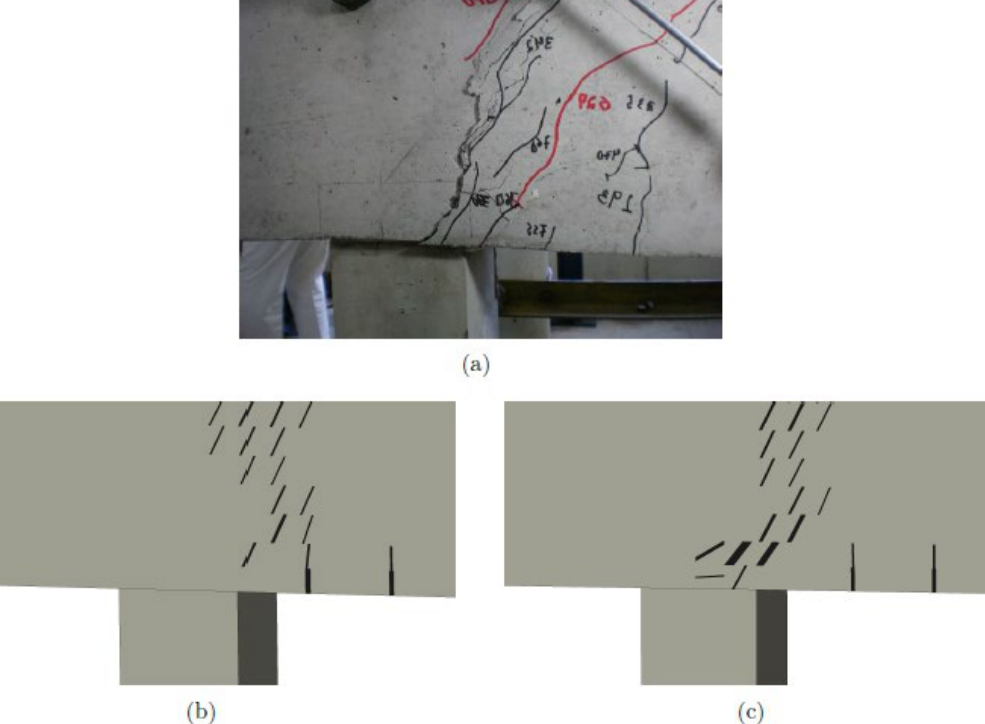
Figure 12. Crack conformation in the lower nodal region for the failure load of (a) reference experimental model, (b) numerical model with rigid connection, and (c) numerical model with interface